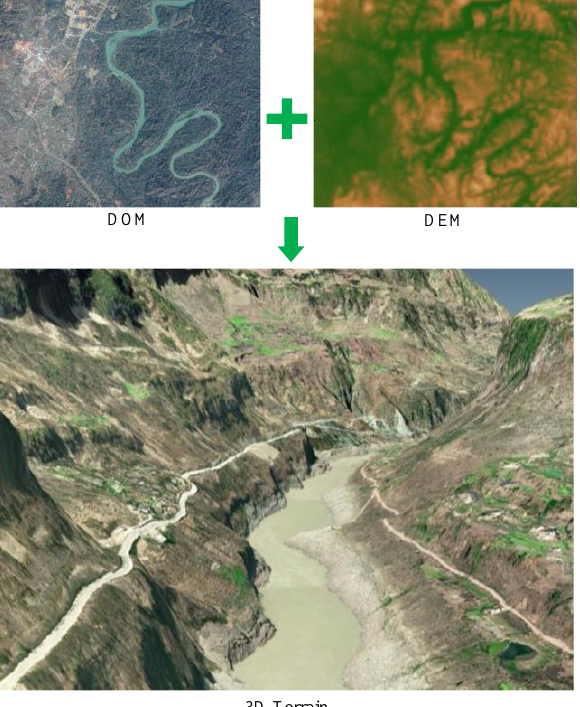
Figure 2. 3D terrain construction